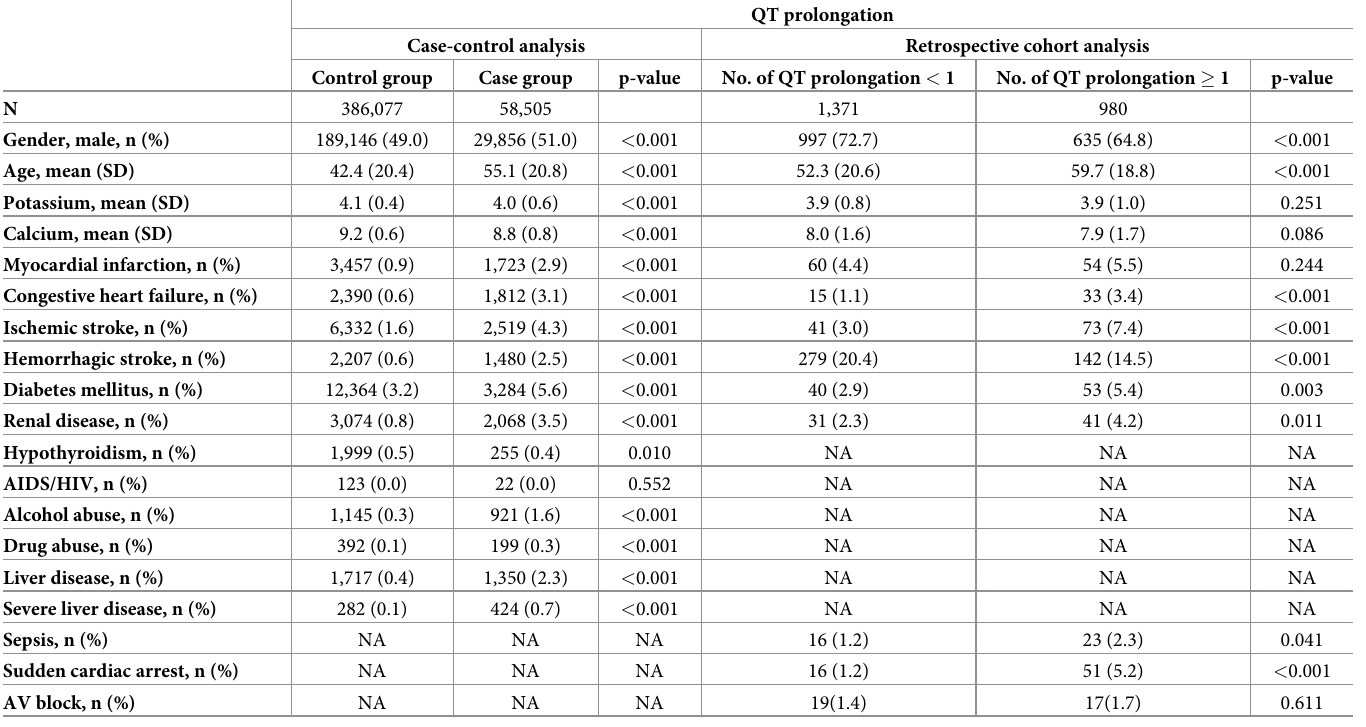
Table 1. Baseline characteristics of subjects.